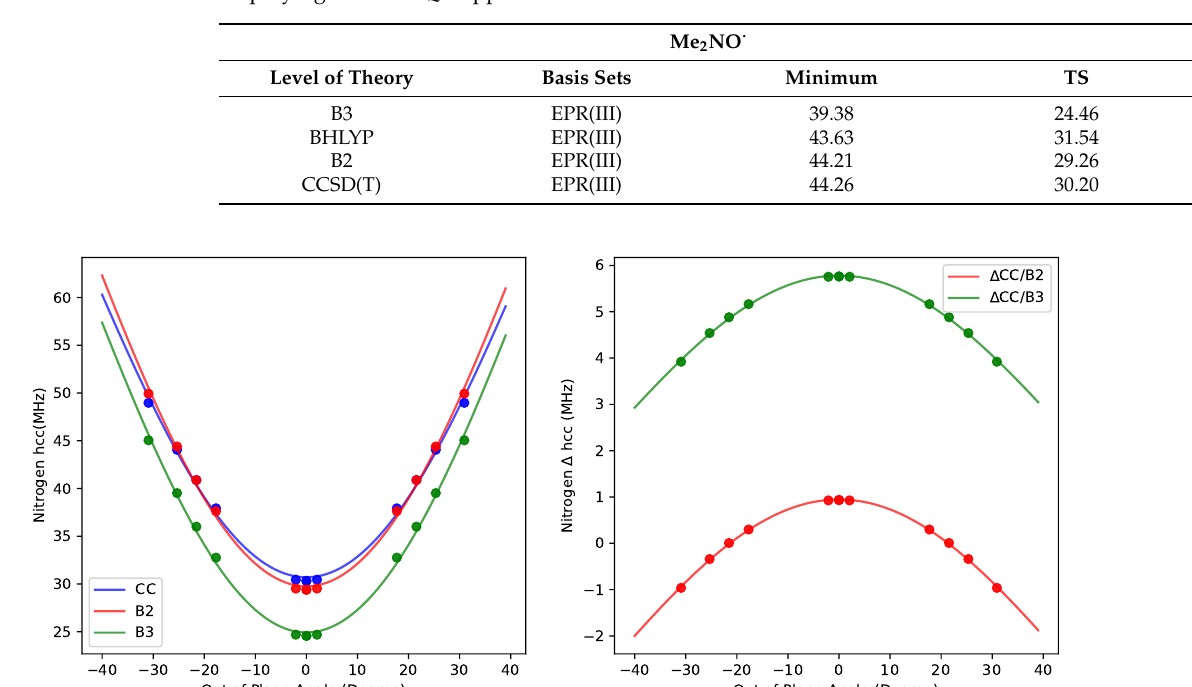
Table 2. a N (in MHz) for the dimethylnitroxide template molecule computed at B2 geometries employing different QC approaches.